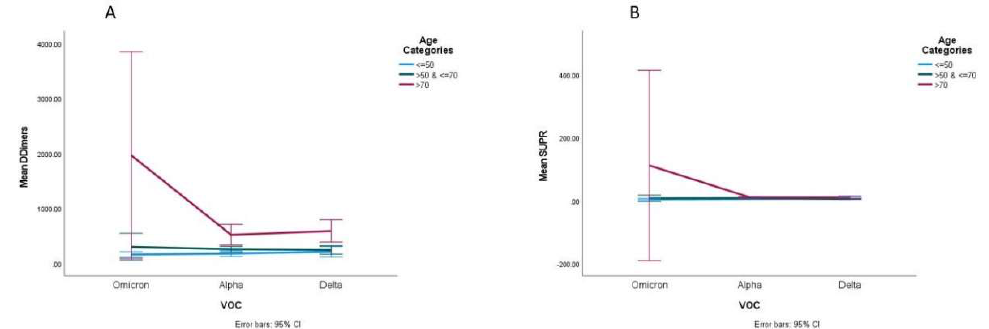
Figure 3. Interaction of SARS-CoV-2 variants and age on D-dimers and suPAR. ( A ) Interaction of SARS-CoV-2 variants and age on D-dimers. The D-dimers values differed significantly among the three VOC subtypes, and patients with Omicron had higher mean values of D-dimers compared to the patients with the other VOC. Two-way ANOVA analysis proved that the main reason for this difference was due to the group of participants aged >70 y, where these differences were greater compared to the other age groups. ( B ) Interaction of SARS-CoV-2 variants and age on suPAR. The suPAR values differed significantly among the three VOC subtypes, and patients with Omicron had higher mean values of suPAR compared to the patients with the other VOCs. Two-way ANOVA analysis proved that the main reason for this difference was due to the group of participants aged >70 y, where these differences were greater compared to the other age groups.